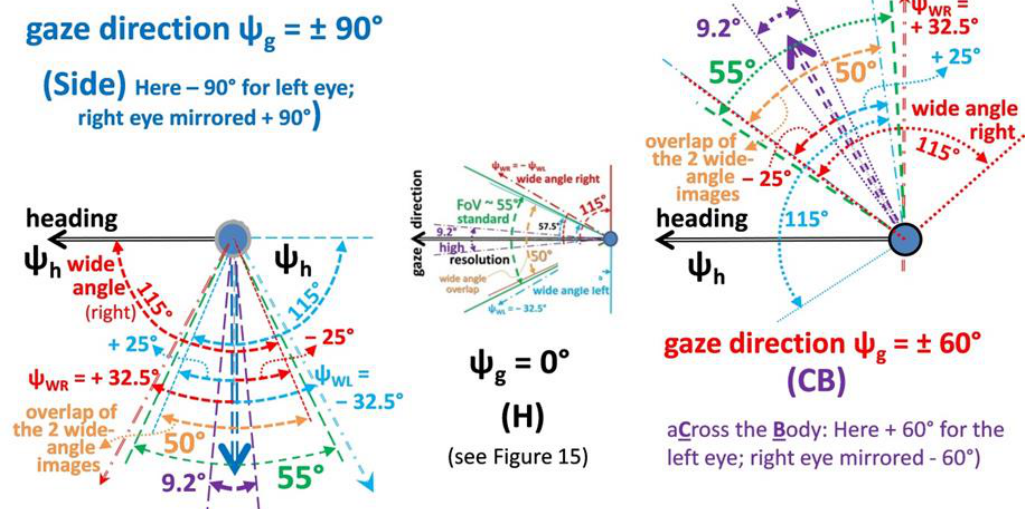
Figure 18. Trifocal gaze-controlled (left-side) ‘vehicle eye’ with four cameras: (Side, at left): Looking −90° to the left (relative to the heading direction of the vehicle); (H) miniaturized Figure 15 looking straight ahead; (CB, at right) extreme gaze direction in azimuth across the body is + 60°. The eye on the right-hand side is vertically mirrored (+90° and −60°).